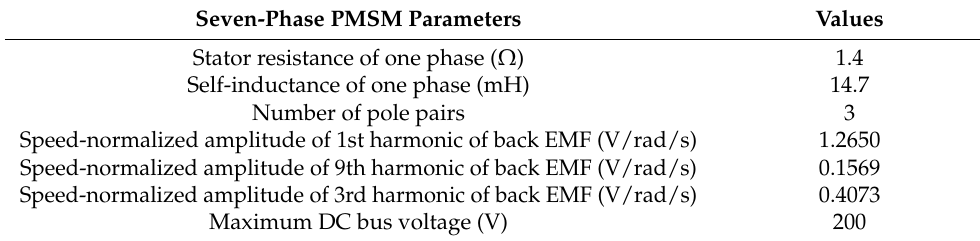
Speed-normalized amplitude of 1st harmonic of back EMF (V/rad/s)